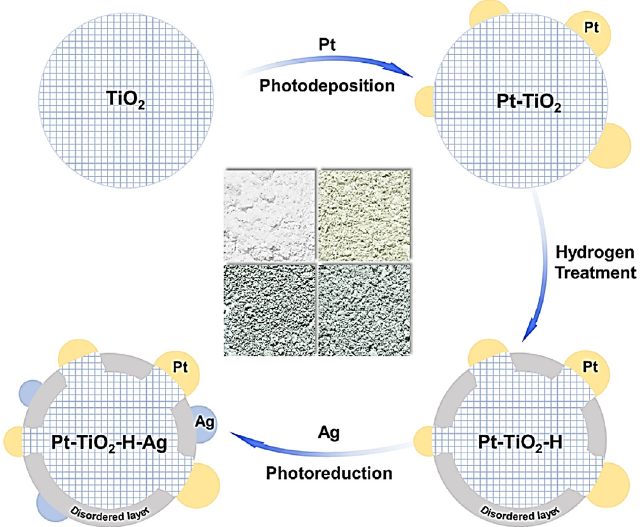
Figure 3. Scheme with photographs for the fabrication of Pt–TiO 2 –H–Ag nano heterostructure. Copyrights 2020 Elsevier [68].